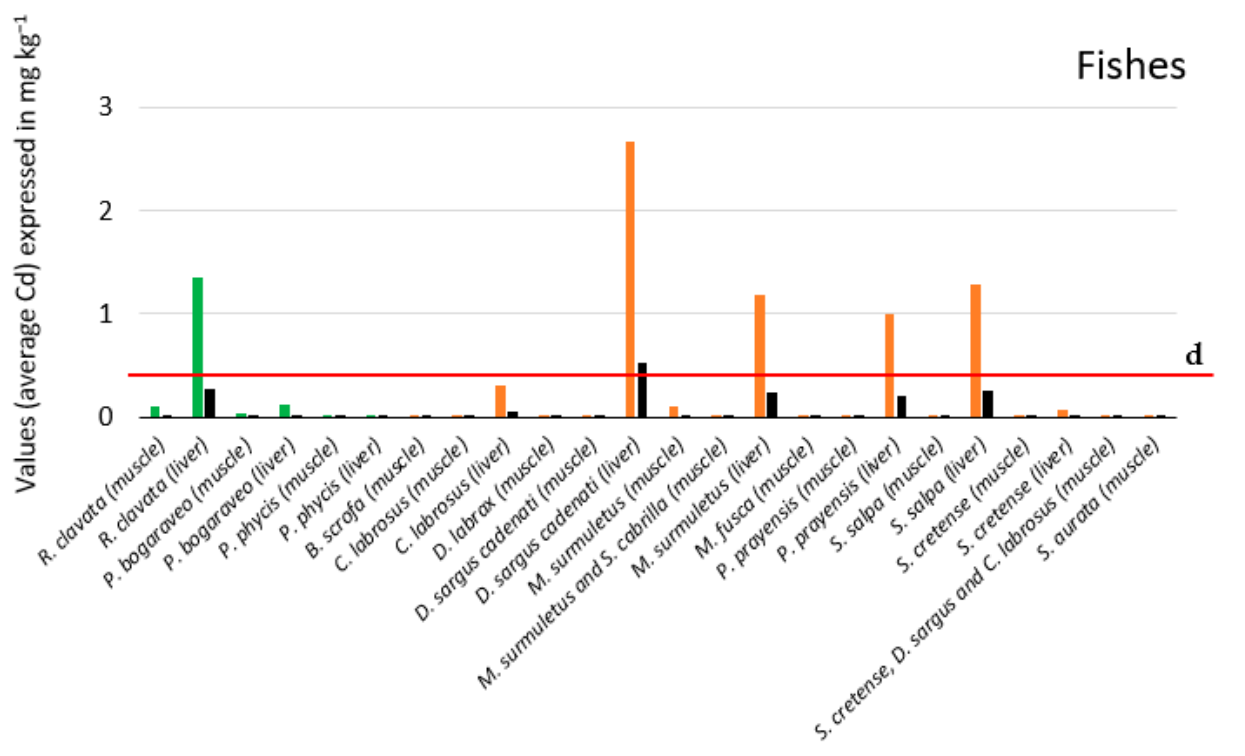
Figure 6. Cadmium content (mean mg kg − 1 dry weight) according to several taxa. Green columns represent Azores studies, orange columns represent studies performed in the Canaries, and black columns represent values in wet weight. Red lines represent maximum levels of cadmium, in wet weight, according to Regulation (EC) No 1881/2006: ( a ) 0.05 (seaweeds), ( b ) 0.5 (crustaceans), ( c ) 1 (mollusks), and ( d ) 0.05 (fishes).